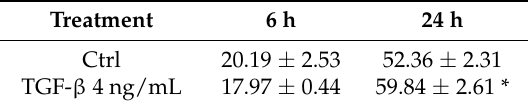
Table 3. In vitro wound-healing rate of the untreated control (% of wound closure ± standard deviation). * <0.05 vs